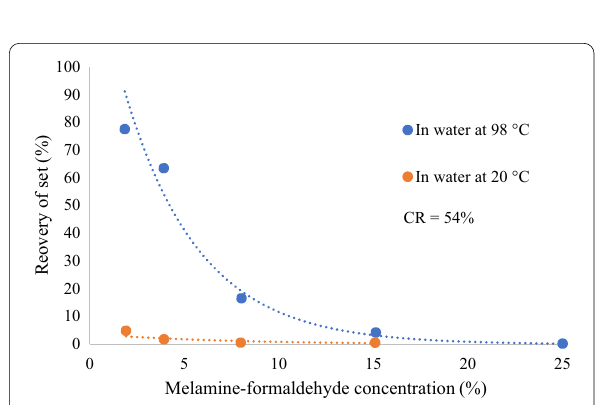
Fig. 13 Effect of MF concentration on SR ( reproduced from Inoue et al.